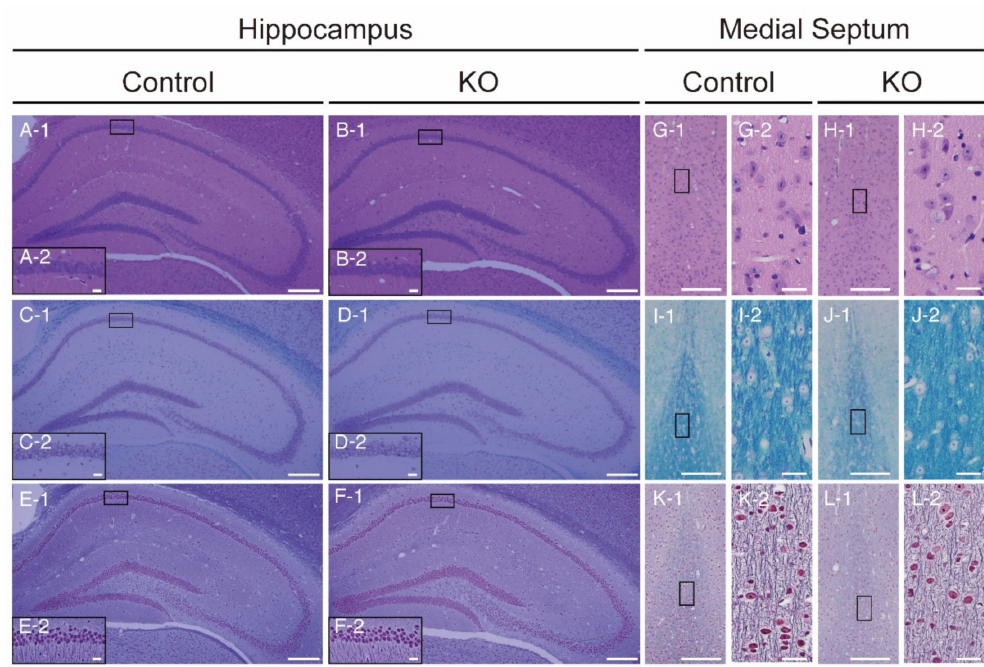
Figure 2. Morphological assessment of the HCNP-pp KO brain (hippocampus: A – F ; medial septum: G – L ). Haematoxylin-eosin staining (A-1,2, G-1,2: Control; B-1,2, H-1,2: HCNP-pp KO),